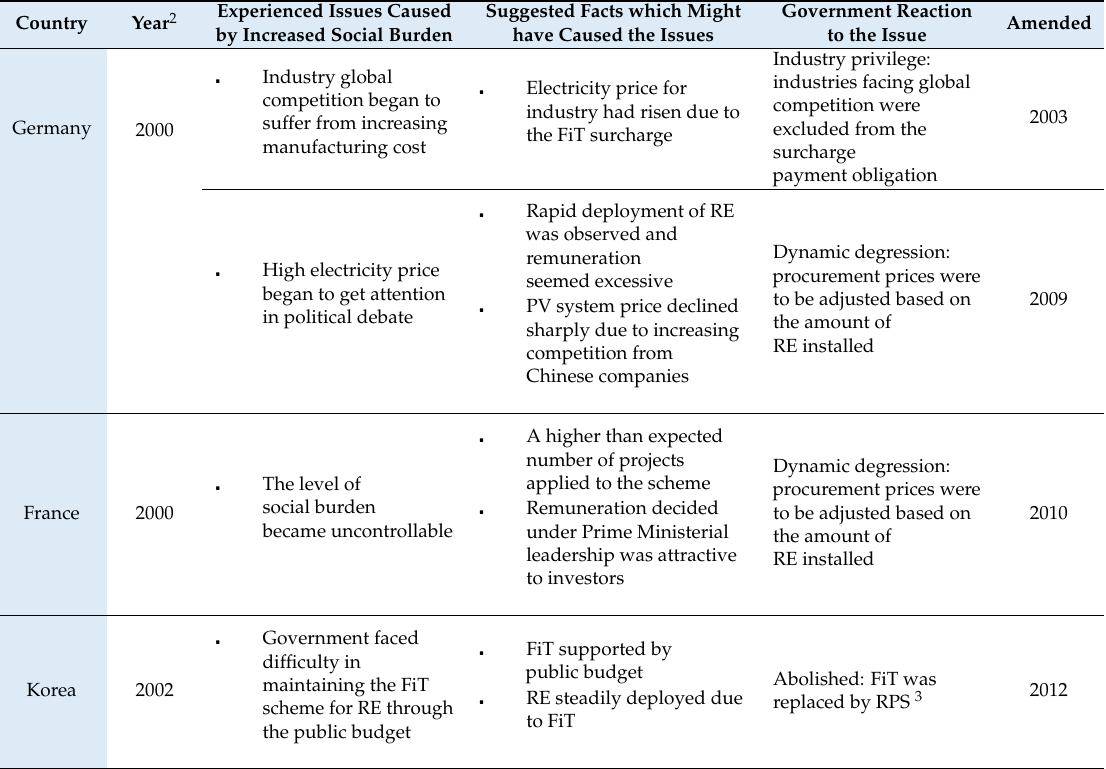
Table 3. FiT experience and outcomes in major PV deploying and manufacturing